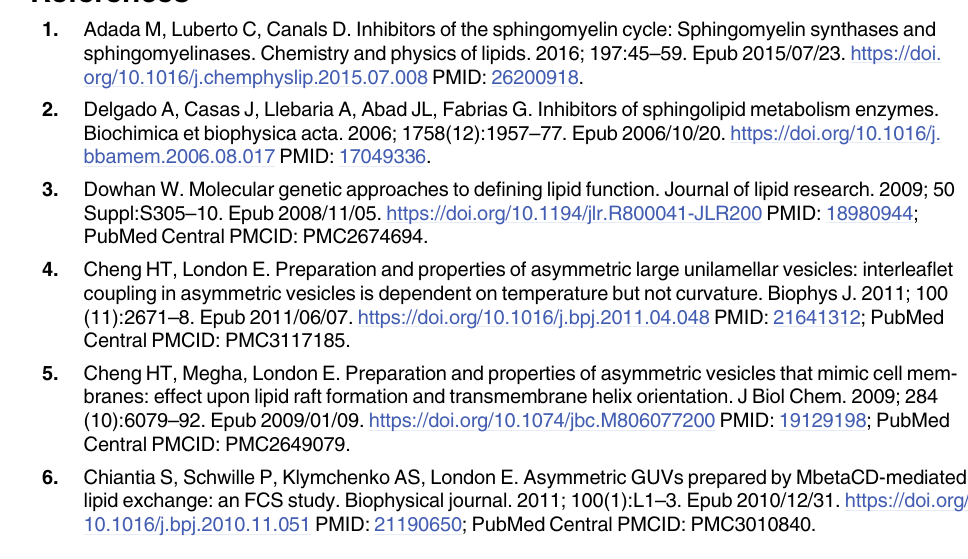
S4 Fig. Example of TLC analysis of lipids after lipid exchange at 27˚C. HP-TLC of A549 cells after 1h exchange and 2h recovery. Cells were incubated with 1 mM SM or 4 mM PC (exogenous lipid type shown under TLC) without M α CD or in exchange medium containing lipid vesicles mixed with M α CD. Levels of SM quantified using imageJ densitometry scan and are shown above the SM bands (see arrow). Exchange was carried out in 10 cm diameter plates at 27˚C with 3 ml of lipid plus 40 mM M α CD. Recovery was carried out at 37˚C in the same plates with 5 ml of complete growth medium. Similar results were observed in a second TLC experiment. S5 Fig. Raw flow cytometry data with axis values shown for: A. Fig 3C or B. Fig